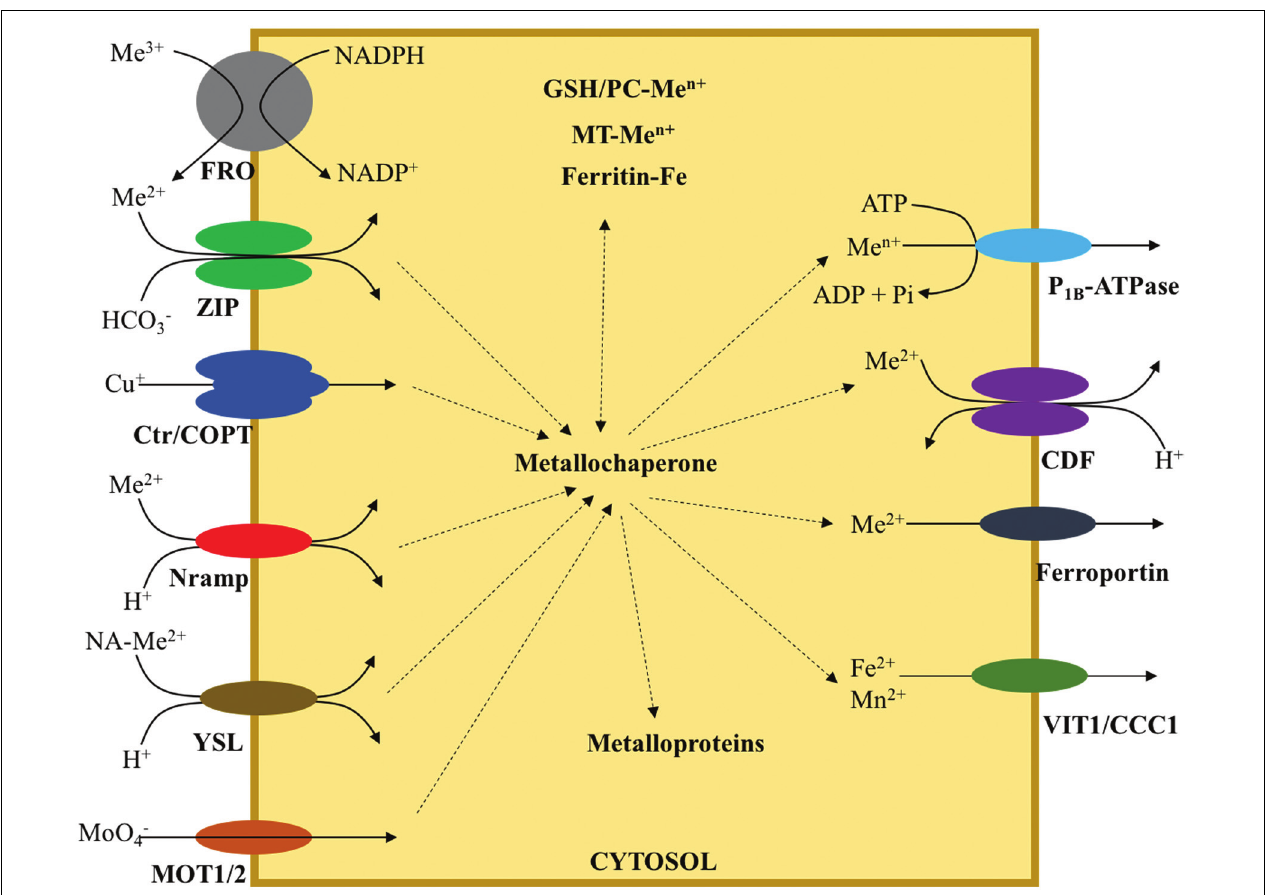
FIGURE 1 | Main systems involved in metal transport and intracellular trafficking. Co-transported ion is indicated where known. Dotted arrows indicate exchange of metal